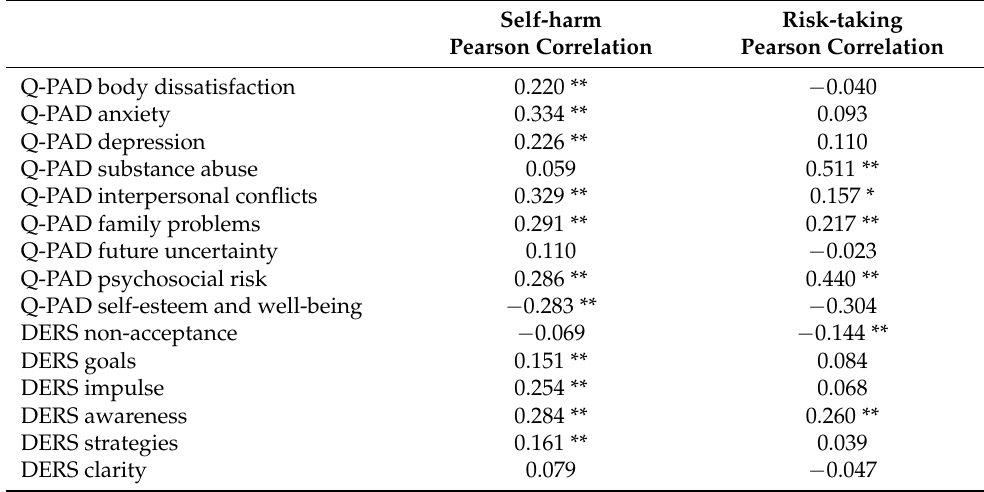
Table 7. Correlations with Q-PAD and